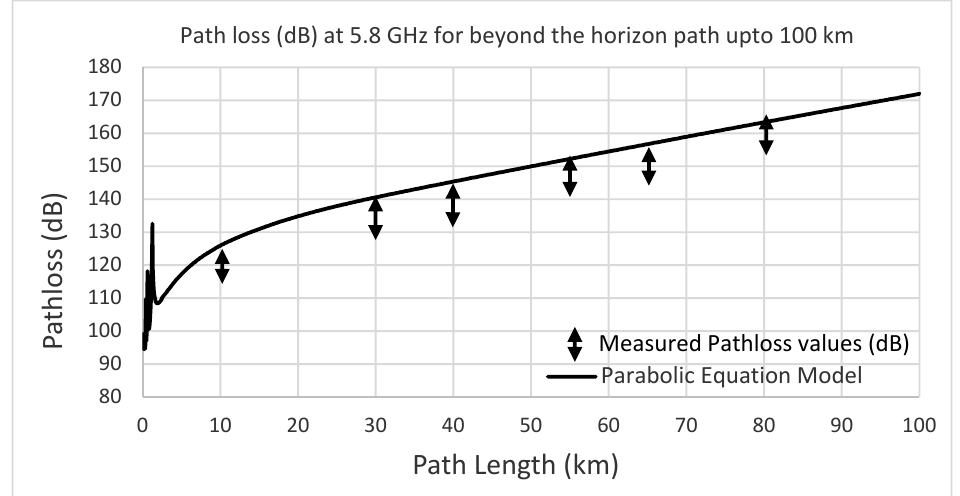
Figure 6. Measured path loss variations shown on the P.E equation-based simulation of predicted path loss.